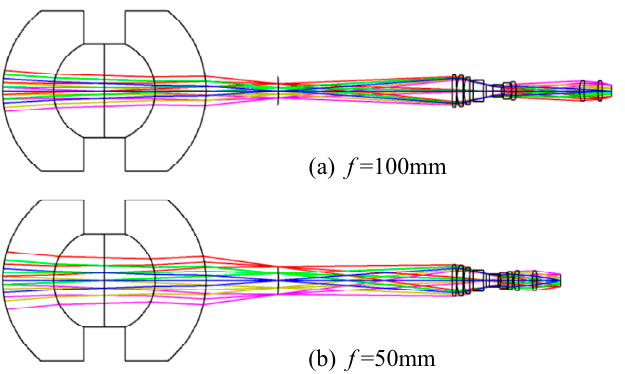
Figure 14. Configurations of the zoom concentric multi-scale optical system. ( a ) focal length f = 100 mm, ( b ) focal length f = 50 mm.